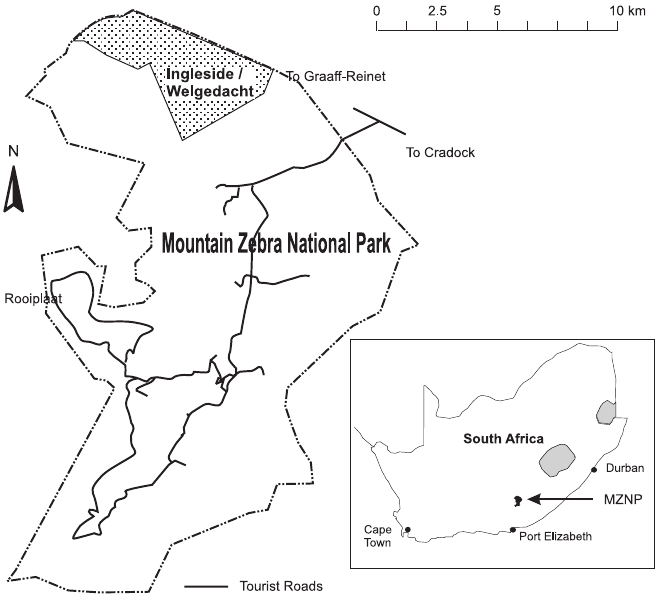
Fig. 1. Location of the study